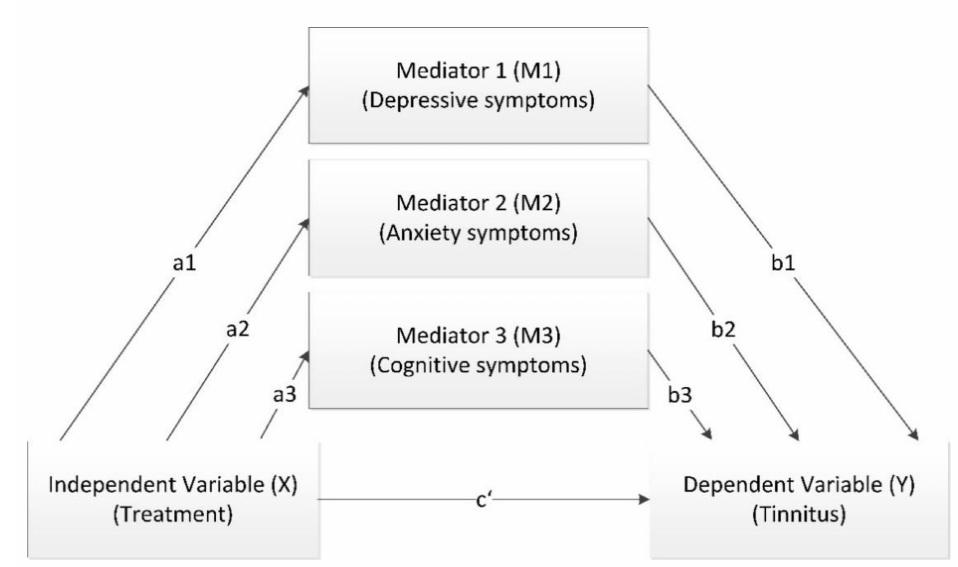
Figure 1. Mediation model with three mediators (please refer to text for